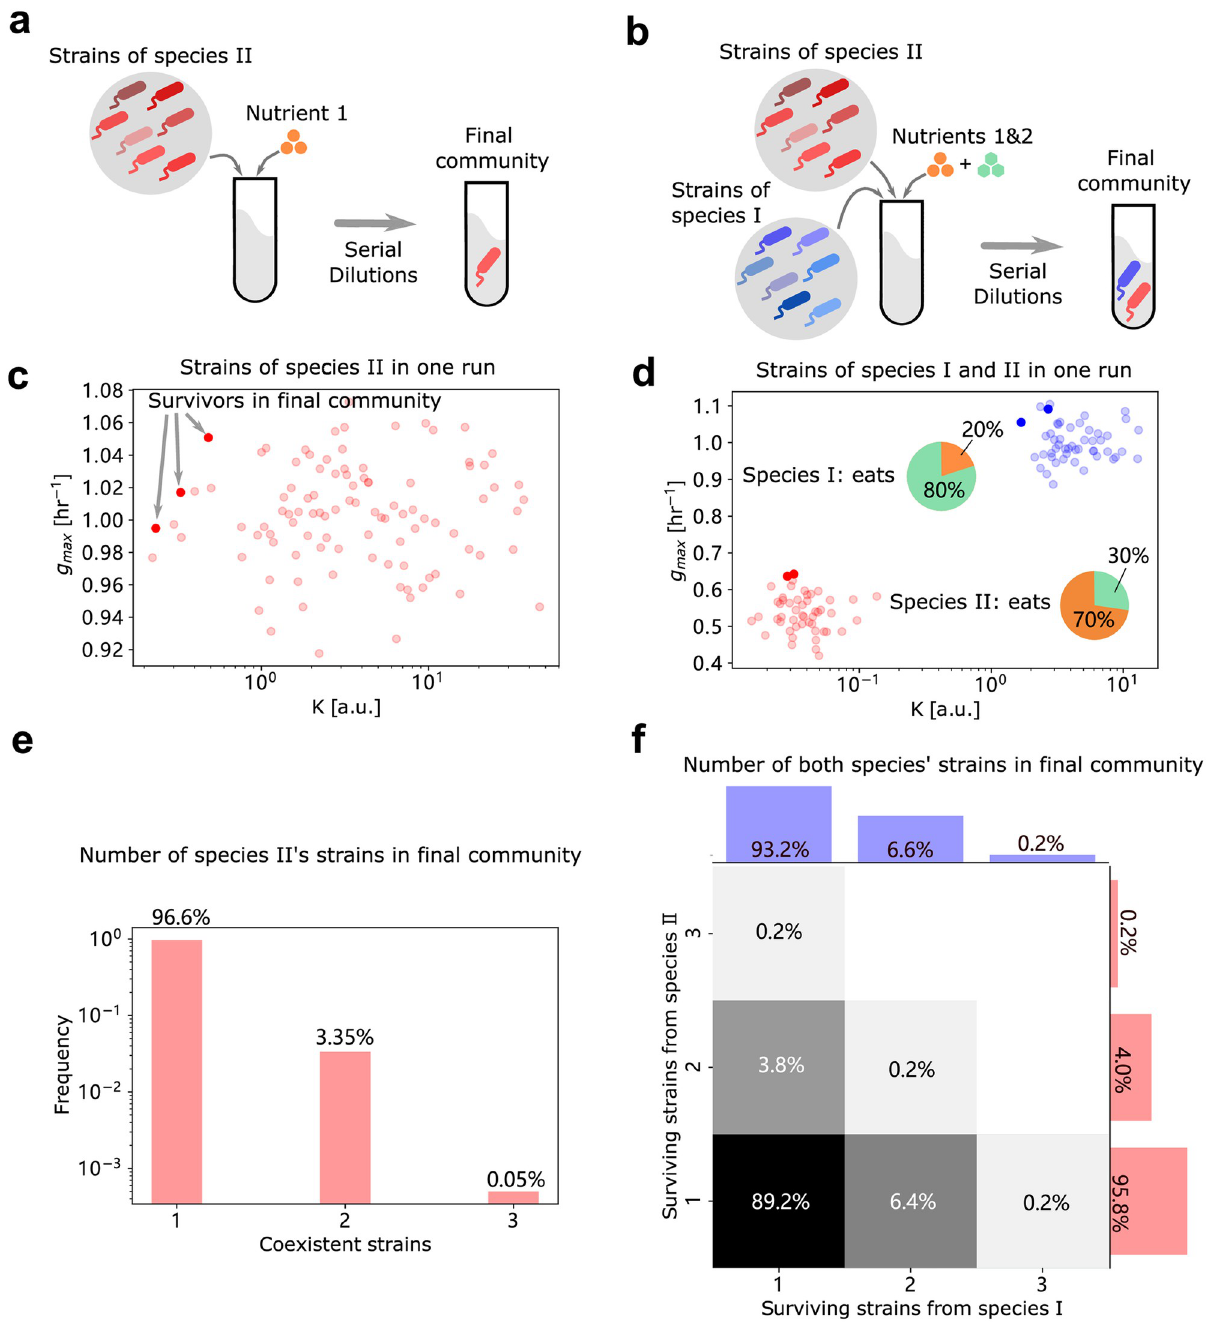
Fig 3. Communities in multi-resource environments. Panels (a)(c)(e) show results from single species in a single resource environment, and (b)(d)(f) depict results from 2 species in a 2-resource environment. (a)-(b) Schematic of strain pool simulations. All randomly generated strains from each species are presented together at the beginning of each serial dilution simulation, which will reach a final community composition at steady state. (c)- and K ’s of each strain, where the deep-colored ones represent the strains that survive in the (d) Examples of strains in a strain pool. Dots show the g max final community. Blue dots are strains from species I and red from species II. Pie charts in (d) show the co-utilization profiles of each species. (e)-(f) Histograms of the number of survivors in the final community. Bar plots of blue and red show correspondingly the number of surviving strains from species I and II. Heatmap in (f) separately represents the joint distribution of the number of survivors in both species.